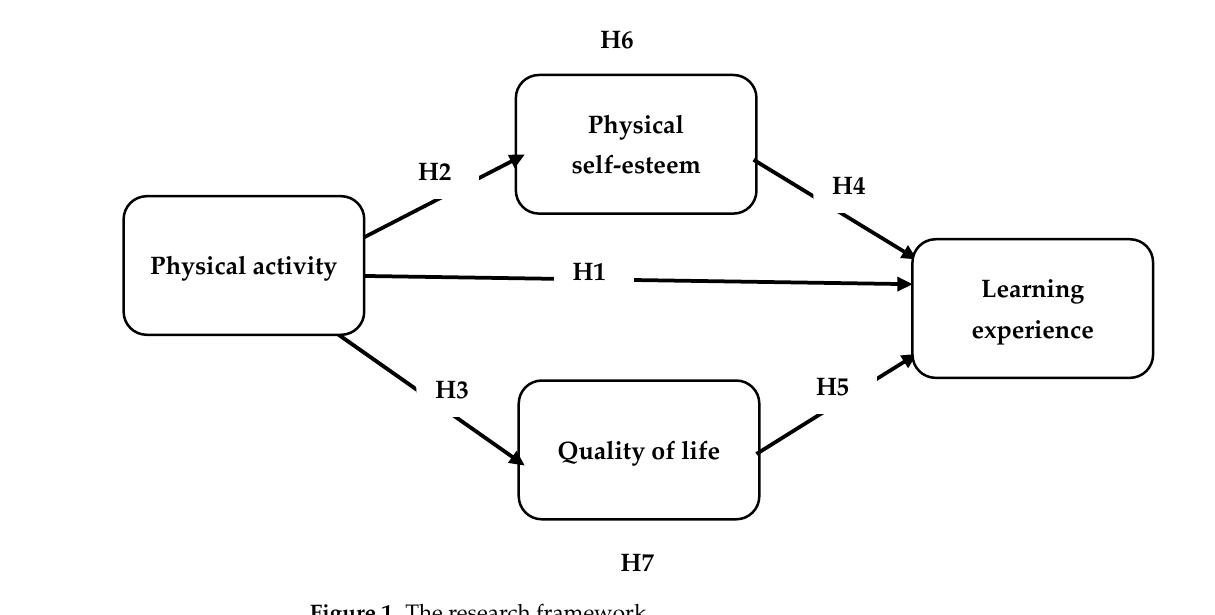
Figure 1. The research framework.